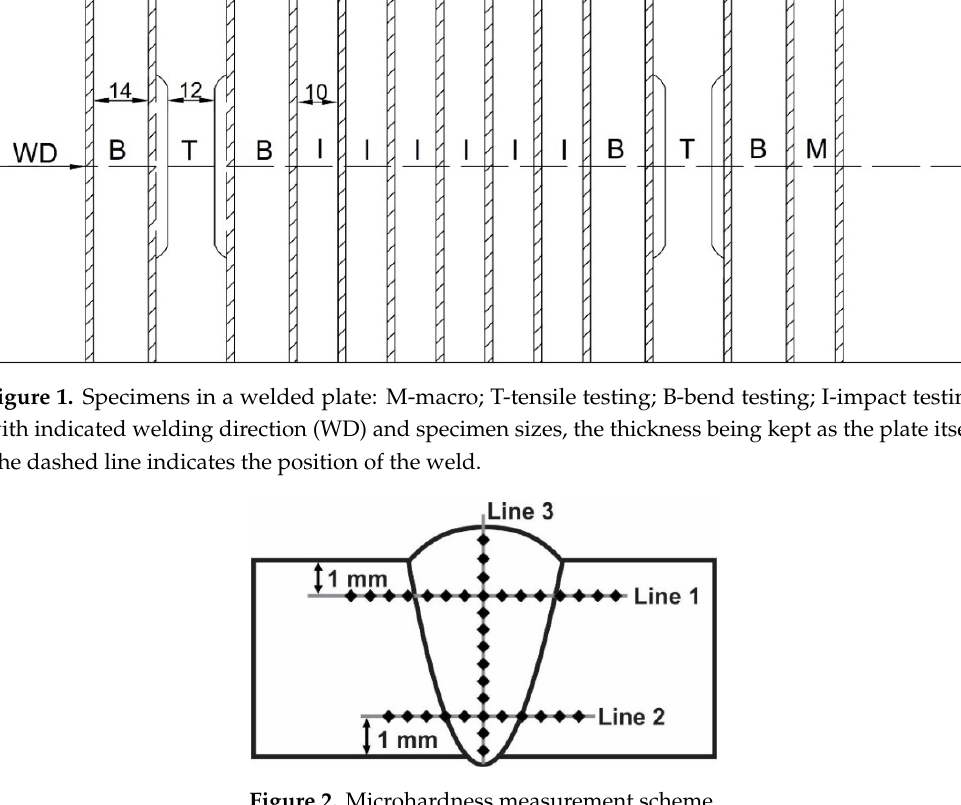
Figure 2. Microhardness measurement scheme.